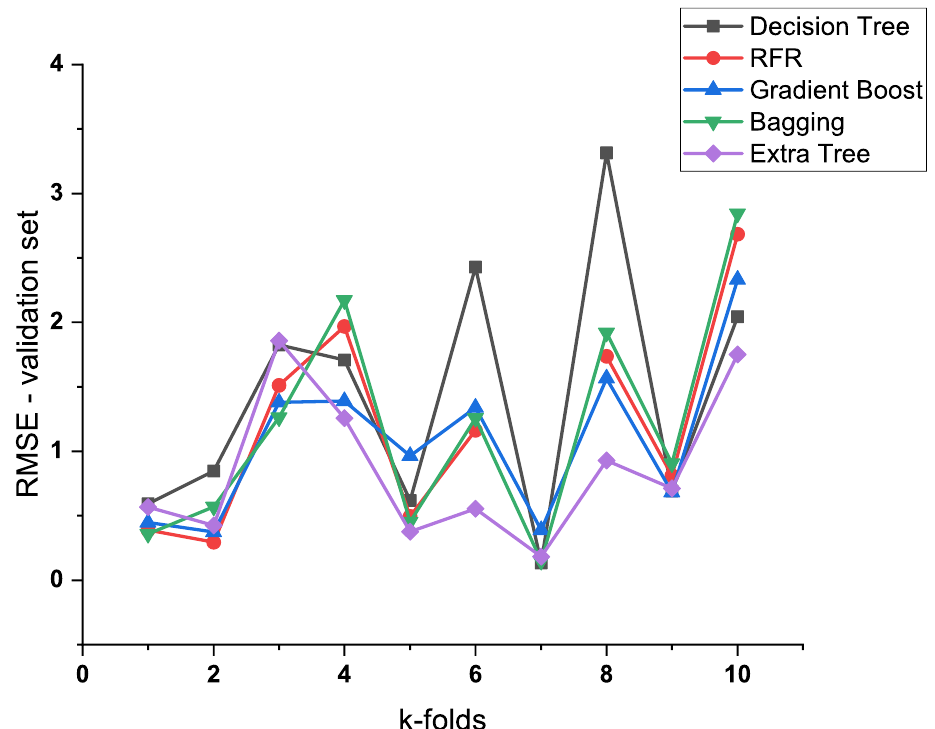
Figure 3. Ten-fold cross-validation comparison of RFR, extra trees, gradient boost, decision tree, and bagging algorithms.